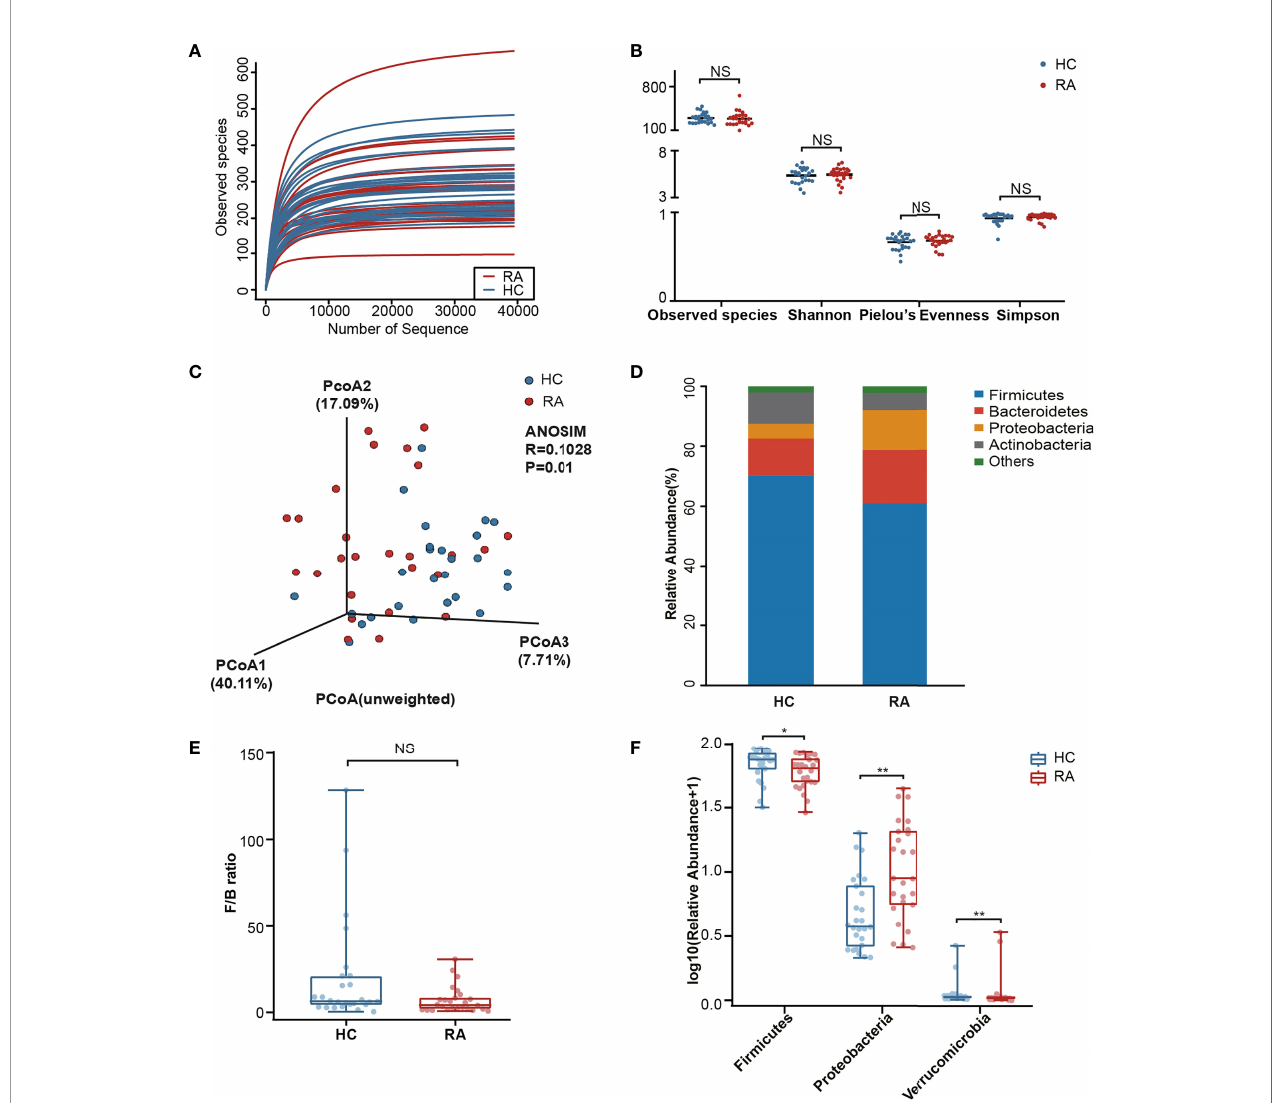
FIGURE 1 | Comparison analysis of species diversity and relative abundance at the phylum level. (A) The curve of each sample was nearly smooth, indicating that the sequencing data was suf fi cient. (B) Alpha diversity was measured by the Observed species, Shannon, Pielou ’ s Evenness and Simpson index. NS, not signi fi cant. (C) Beta diversity was measured by principal coordinate analysis (PCoA) and analysis of similarities (ANOSIM). (D) The distribution plot of relative abundance at the phylum level. (E) The comparison of F/B ratio between the RA patients and healthy controls. NS, not signi fi cant. (F) The Wilcoxon test showed that three phyla were signi fi cantly altered in RA patients. P-value, *p < 0.05; **p <